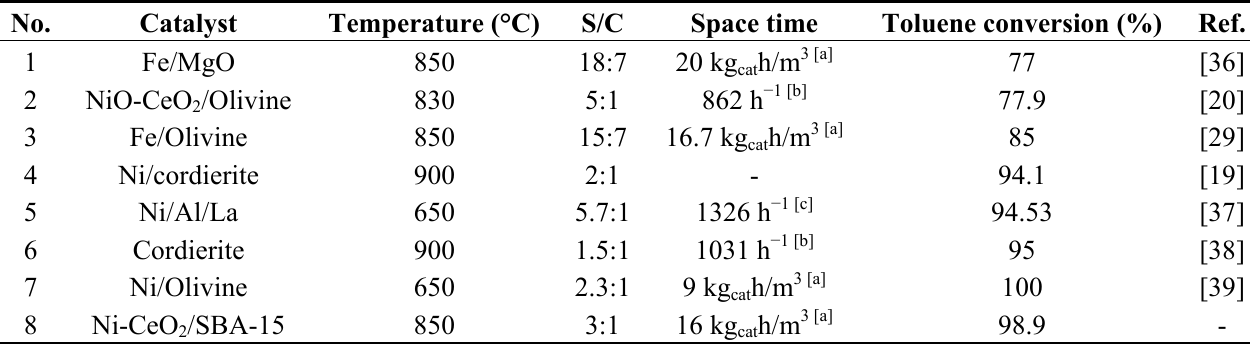
Table 3. Comparison of the catalytic performances of previously reported catalysts and the Ni-CeO (3wt%)/SBA-15 catalyst. 2